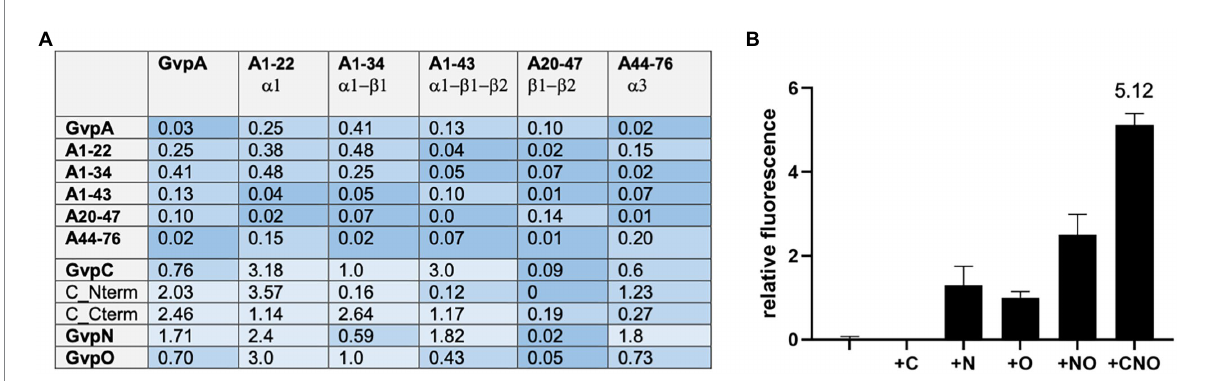
FIGURE 4 Interaction of the A fragments and dimerization of GvpA in presence of C, N, and/or O. The relative fluorescence (rf) obtained by split-GFP analyses is given in LAU/mm 2 . In each case, only the combination with the highest rf value is presented. (A) rf values obtained for the interactions of the different A fragments with each other, and also with GvpA, C, N, O, or the Nterm and Cterm fragments of GvpC. (B) Dimerization of GvpA in the presence of GvpC, N, and/or